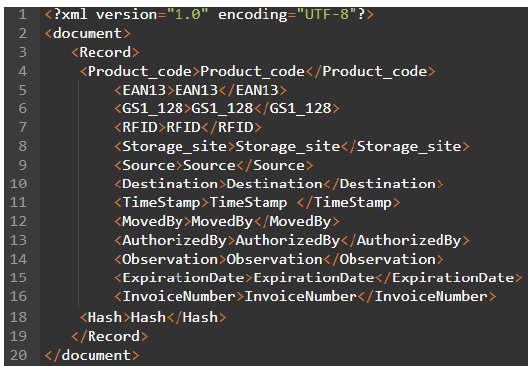
Figure 10. Data on agrochemical packages used within the farm.